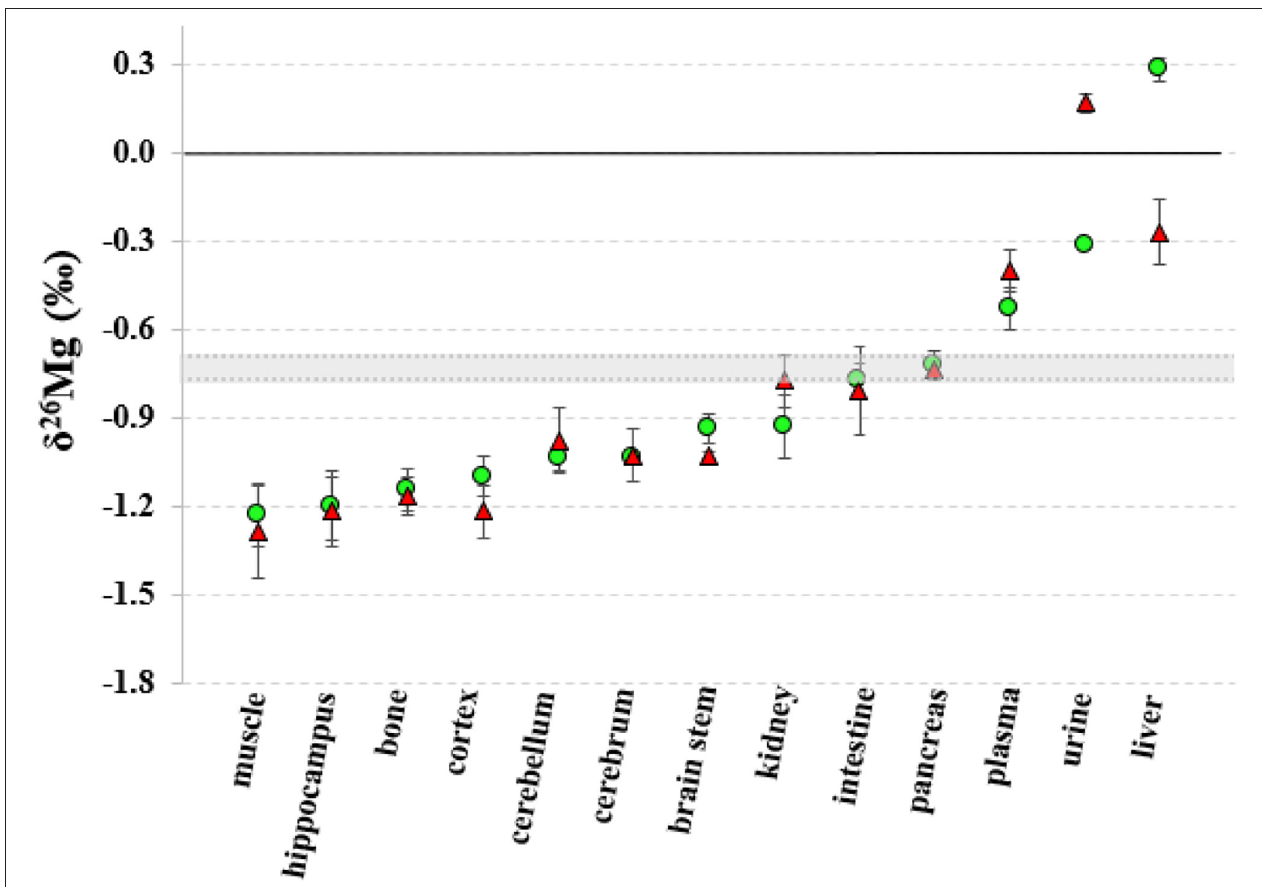
FIGURE 3 | Body distribution of the Mg isotopes in aged controls and LPS-injected mice. Green circles correspond to the control mice, red triangles to the LPS-injected mice and the gray area corresponds to the Mg isotopic composition of the food. Error bars indicate the standard